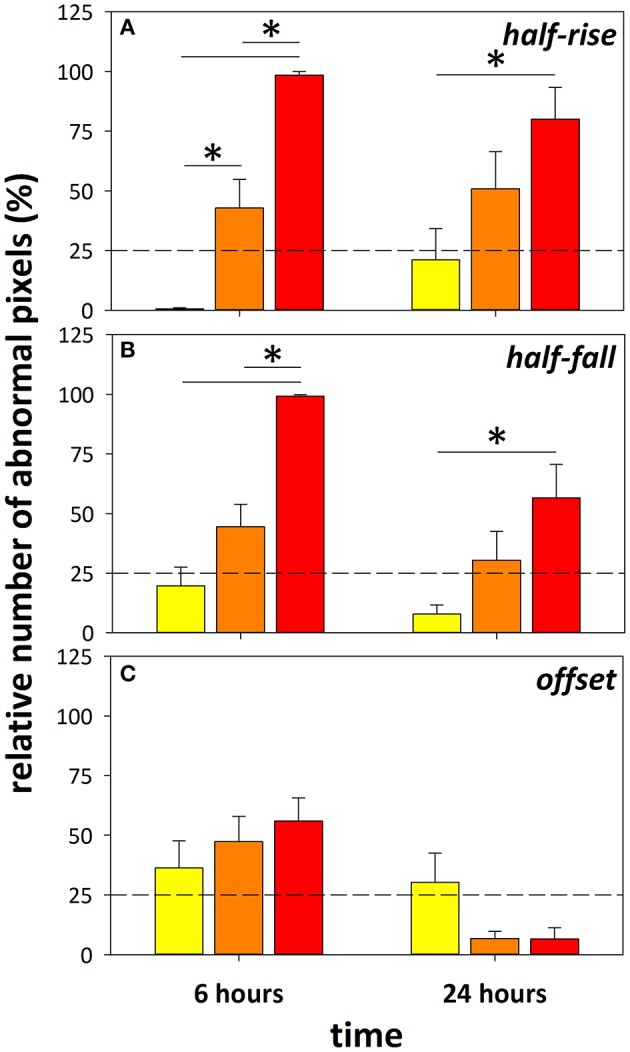
Using the retina as a platform to determine optimal concentration of DOC. Index of injury showing the proportion of pixels (%) that fell beyond a 75% criterion cut-off developed from the control group. Data from eyes treated with 0.02 M (yellow), 0.06 M (orange), and 0.2 M (red) DOC at 6 and 24 h in the half-rise (A), half-fall (B), and offset (C) are shown. *Denotes significance between groups with two-way ANOVA and Tukey's multiple comparisons test. Data falling beyond the dashed line marking 25% indicates significant change from control group, mean ± SEM, n = 10 eyes/group.